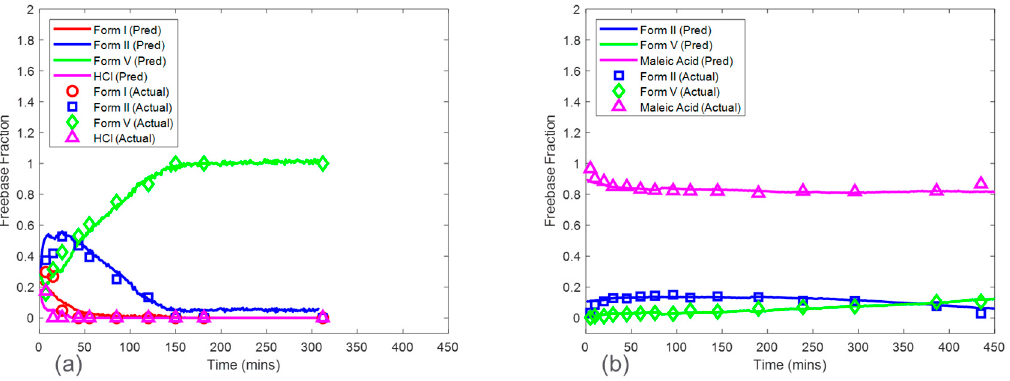
Figure 11. Model predictions of HCl salt ( a ) and maleate salt ( b ) disproportionation from concentration robust modeling procedure for 16.7 mg/mL concentration. Note the relative standard deviation of XRPD reference values was approximately 4%.